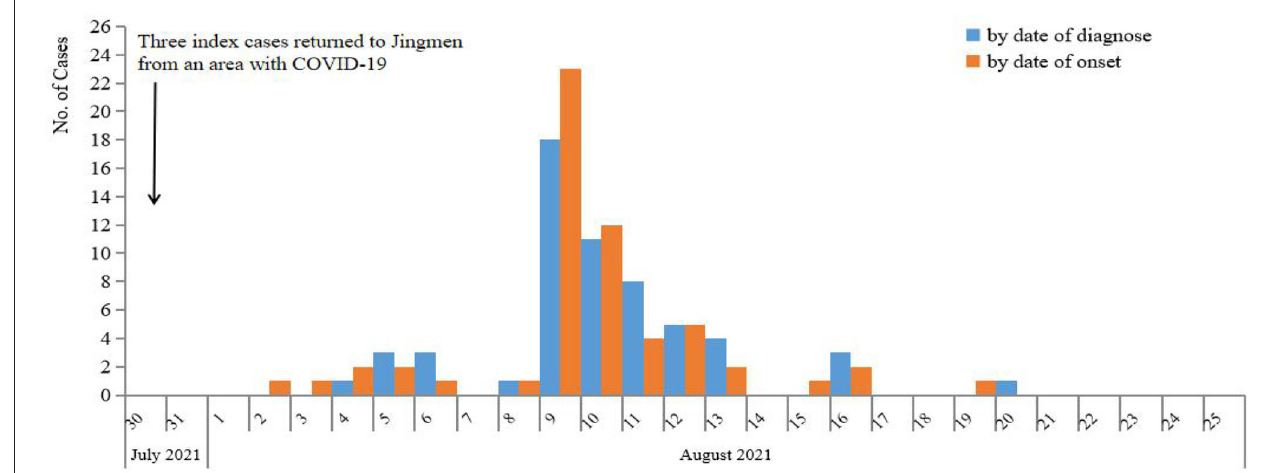
FIGURE 1 | Epidemic curve of COVID-19 cases in Jingmen City, Hubei Province, China in August, 2021.